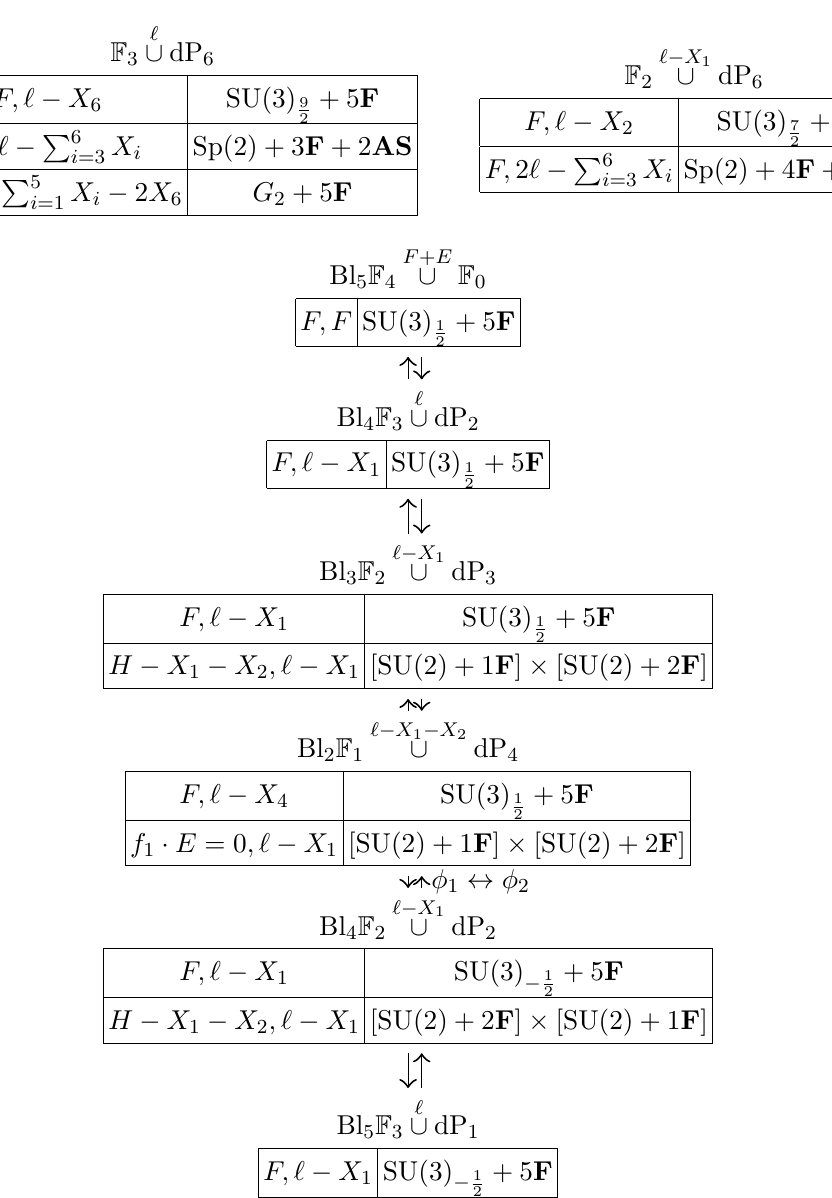
Figure 18. M = 6 geometries,